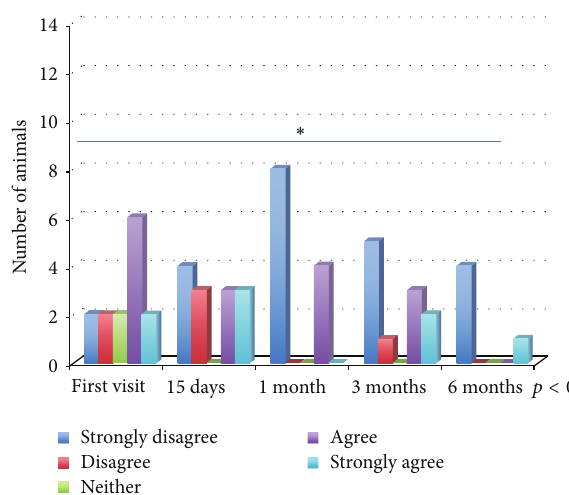
Figure 2: Cardiology: “My animal’s quality of life is compromised by its